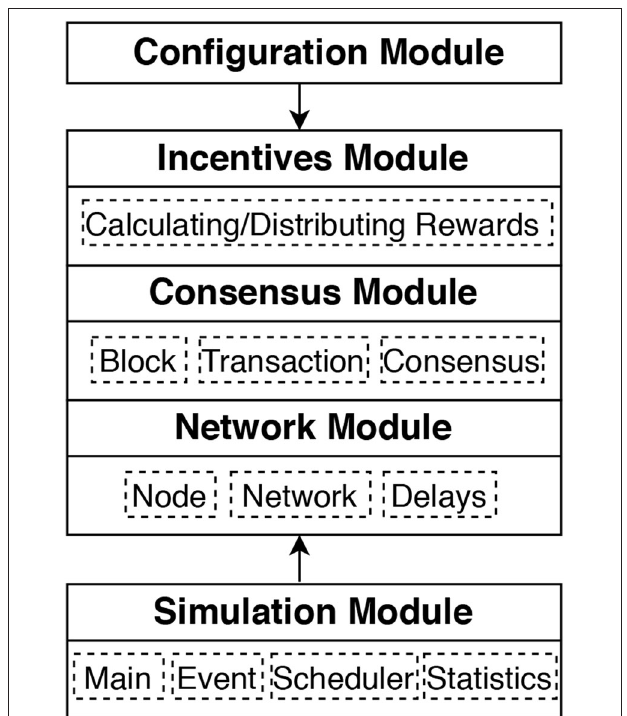
FIGURE 4 | BlockSim implementation